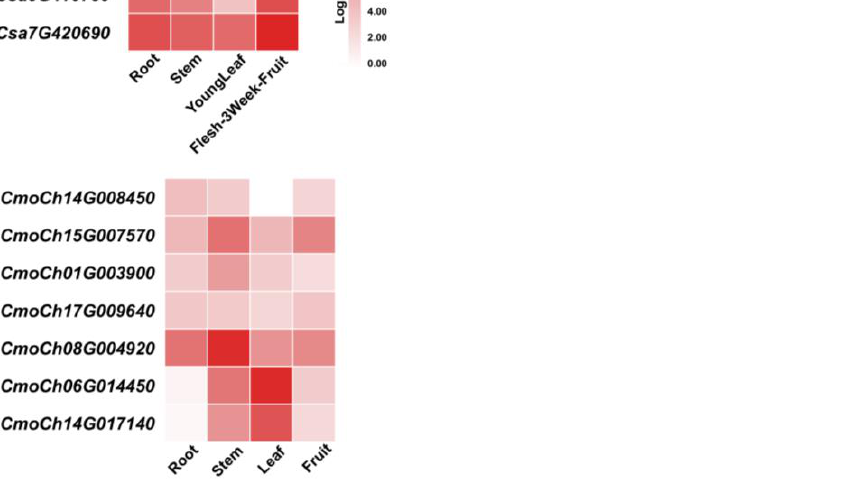
Figure 6. The expression profile of CmoGS and CsaGS family genes. The RNA-seq data are